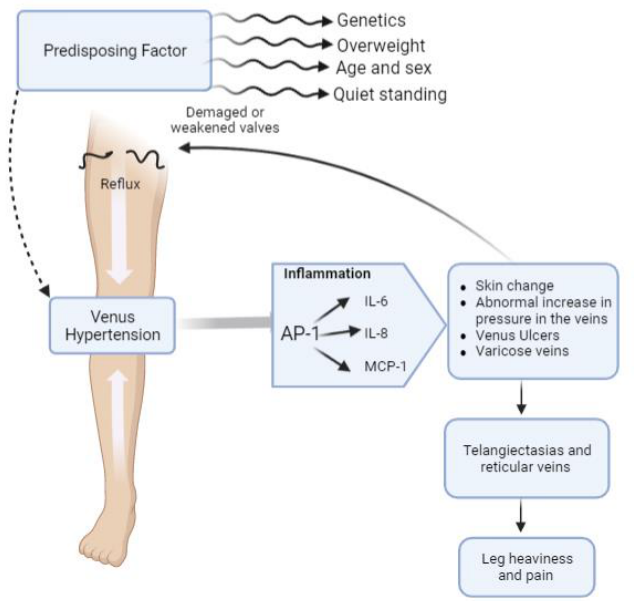
Figure 1. Schematic representation of chronic venous disease (CVD) pathogenesis and major clinical signs.